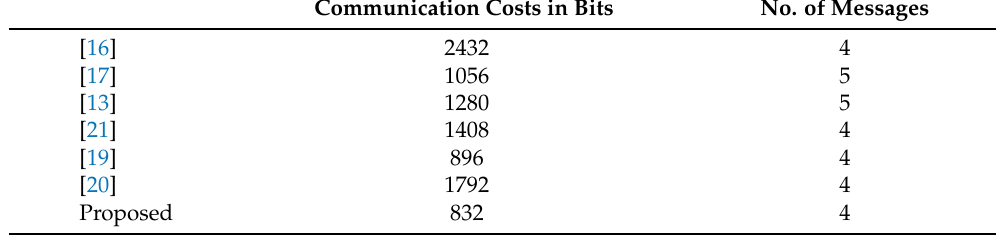
Table 10. Communication cost comparison with relevant frameworks.